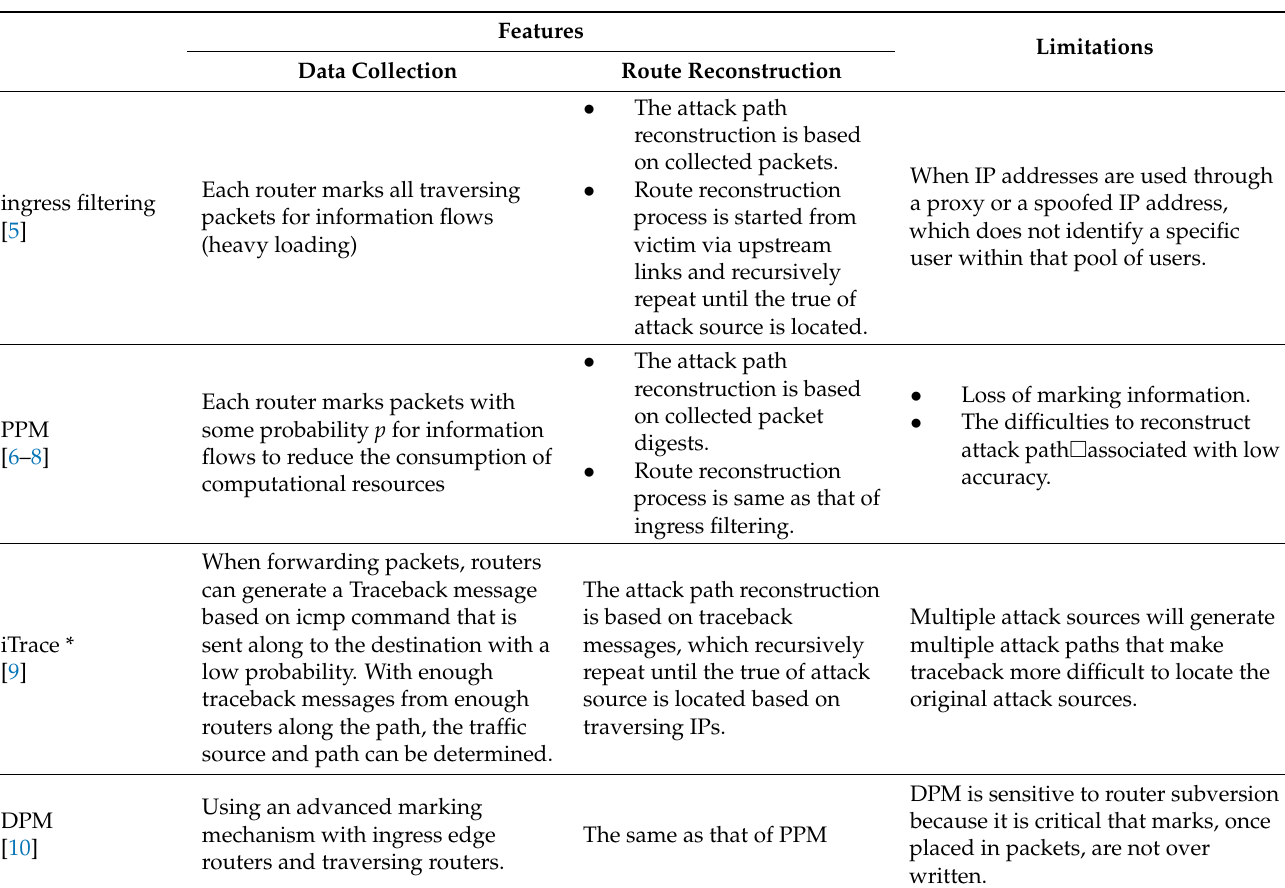
Table 1. Techniques for IP